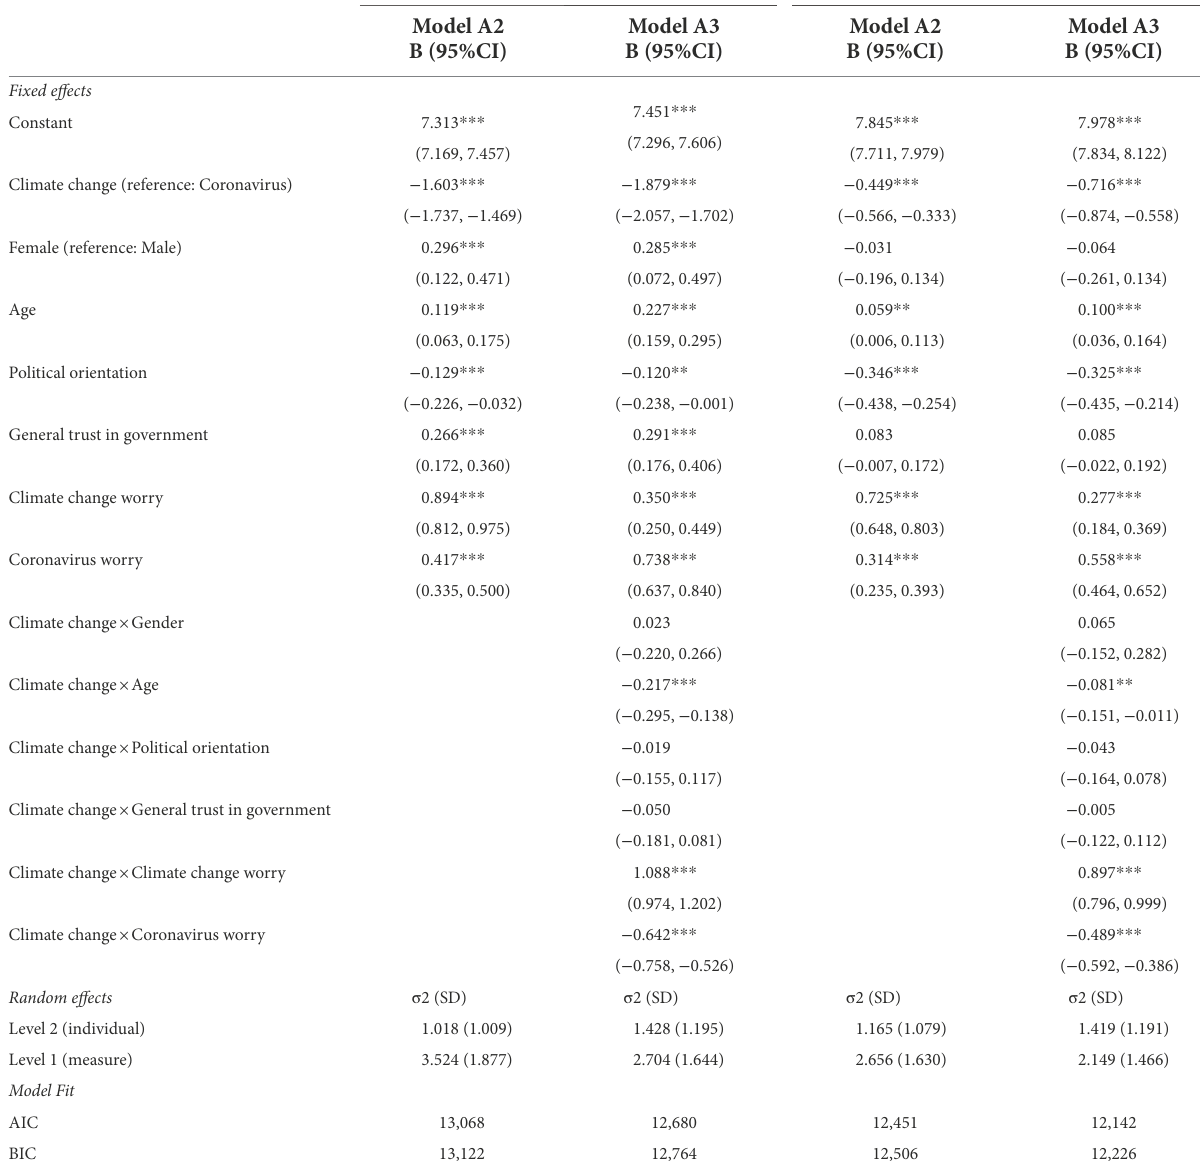
TABLE 3 Perceived personal and government responsibility (Models A2 and